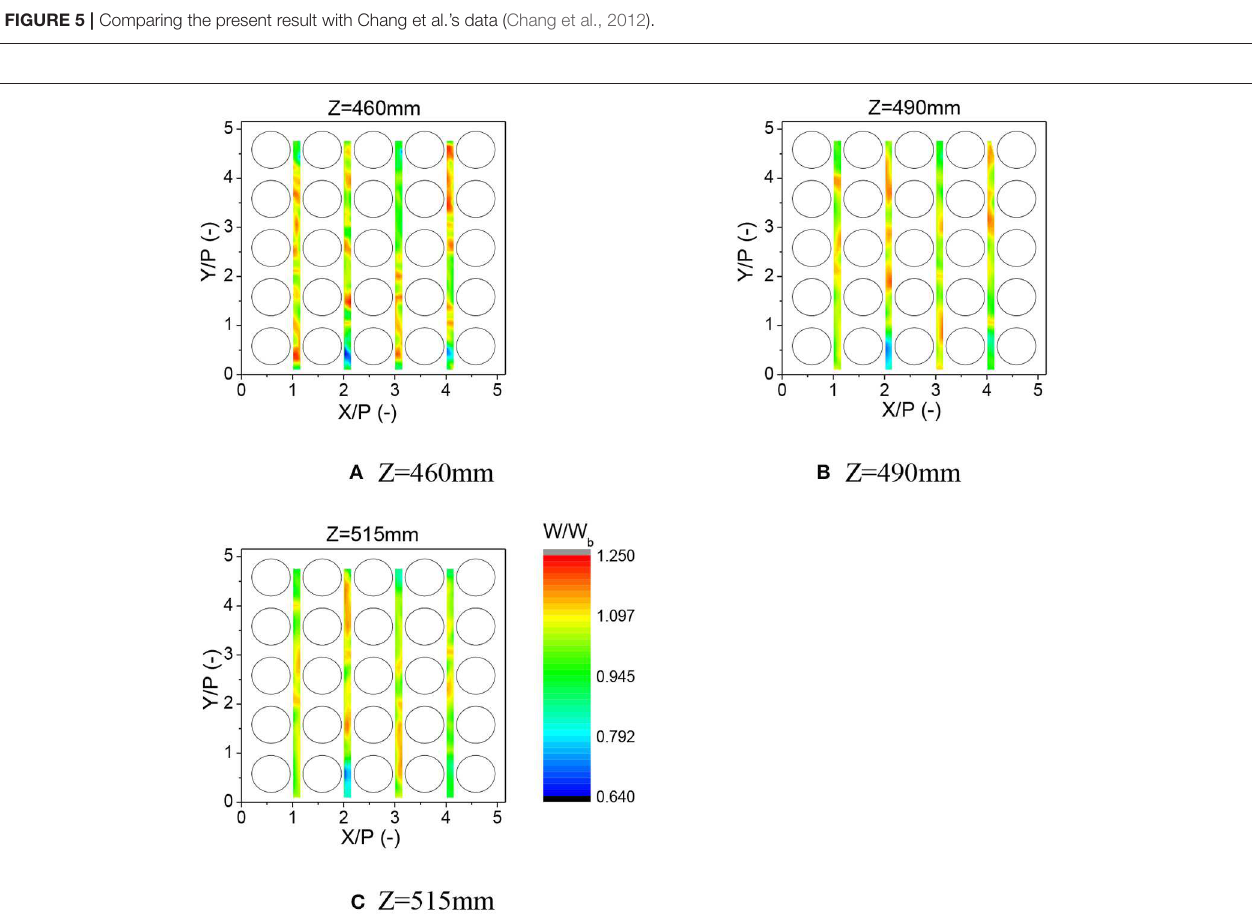
3.6 104). (A) Z 460mm. (B) Z = × =